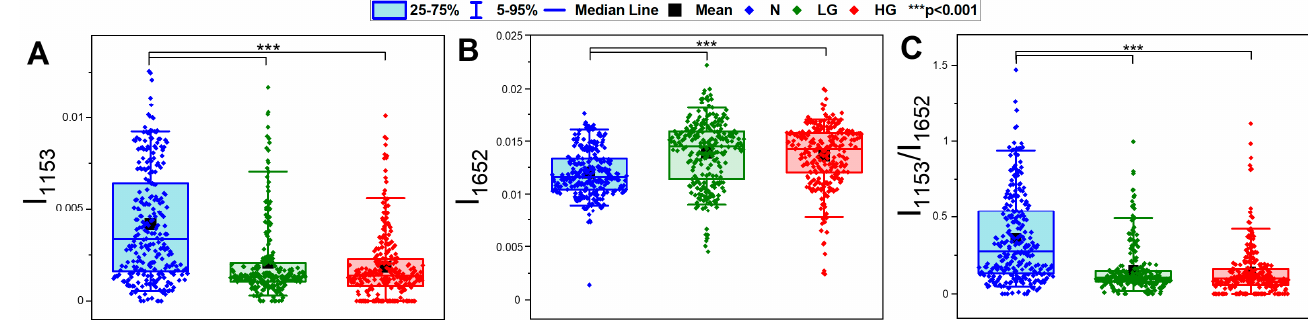
Figure 3. The integration of: ( A ) glycogen (1153 cm − 1 ), ( B ) proteins (1652 cm − 1 ), and ( C ) carbohydrate/protein ratio. Integral intensities were calculated from second-derivative FTIR spectra; 270 spectra per each group (810 in total).